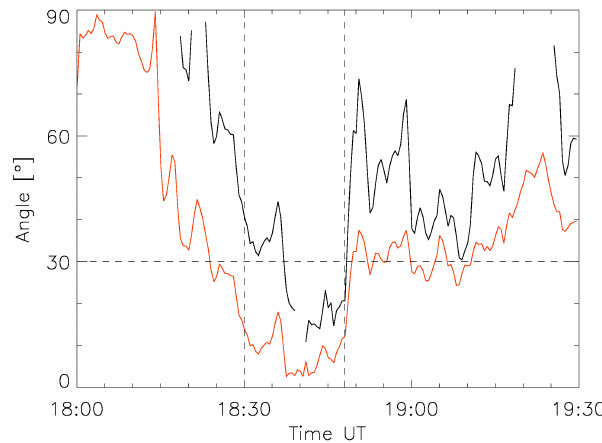
Fig. 12. The black trace shows the angle θ nB between the IMF connected to the Geotail position and the normal of the bow shock surface at the crossing point of the two. The red trace shows the IMF cone angle θ xB .